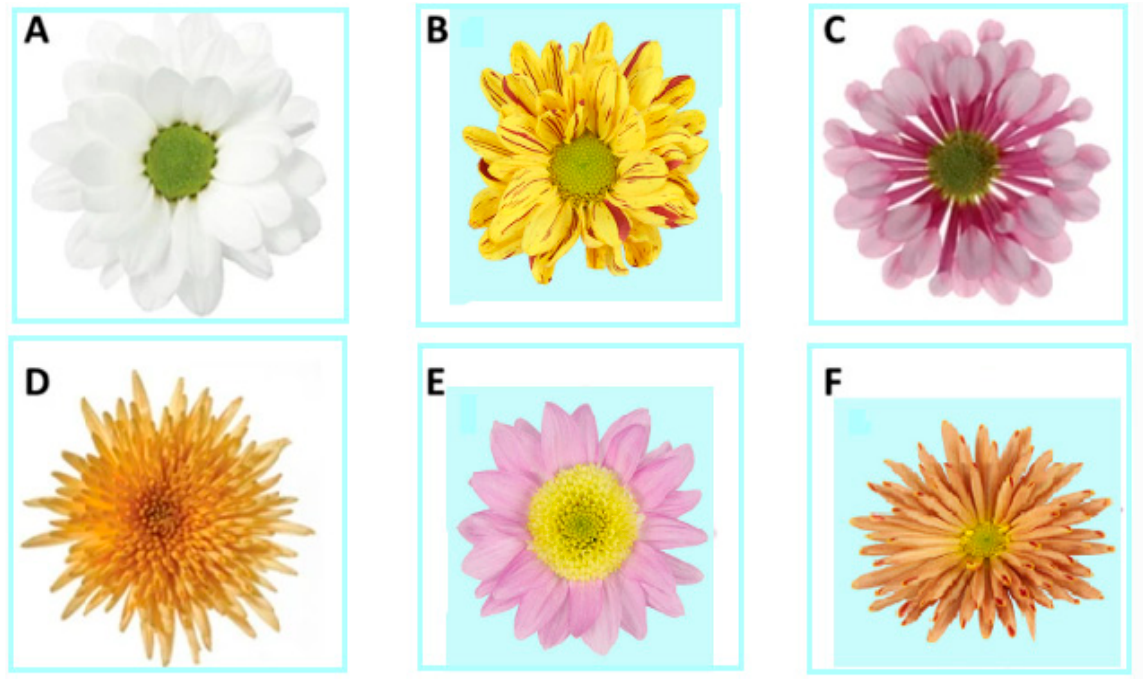
Figure 1. ( A ) The wild-type Chrysanthemum flower shape; ( B ) the double flower type, in which all of the disc florets have turned into the ray florets; ( C ) a spoon type is produced by partially united ray floret petals; ( D ) in combination with the double type, fully united ray florets produce a spider type; ( E ) a form of anemone with colorful and large disc floret petals.; ( F ) An arrangement of totally joined ray floret petals and sizable disc floret petals is known as a spider-anemone. Modified after, Spaargaren and Geest, [4].